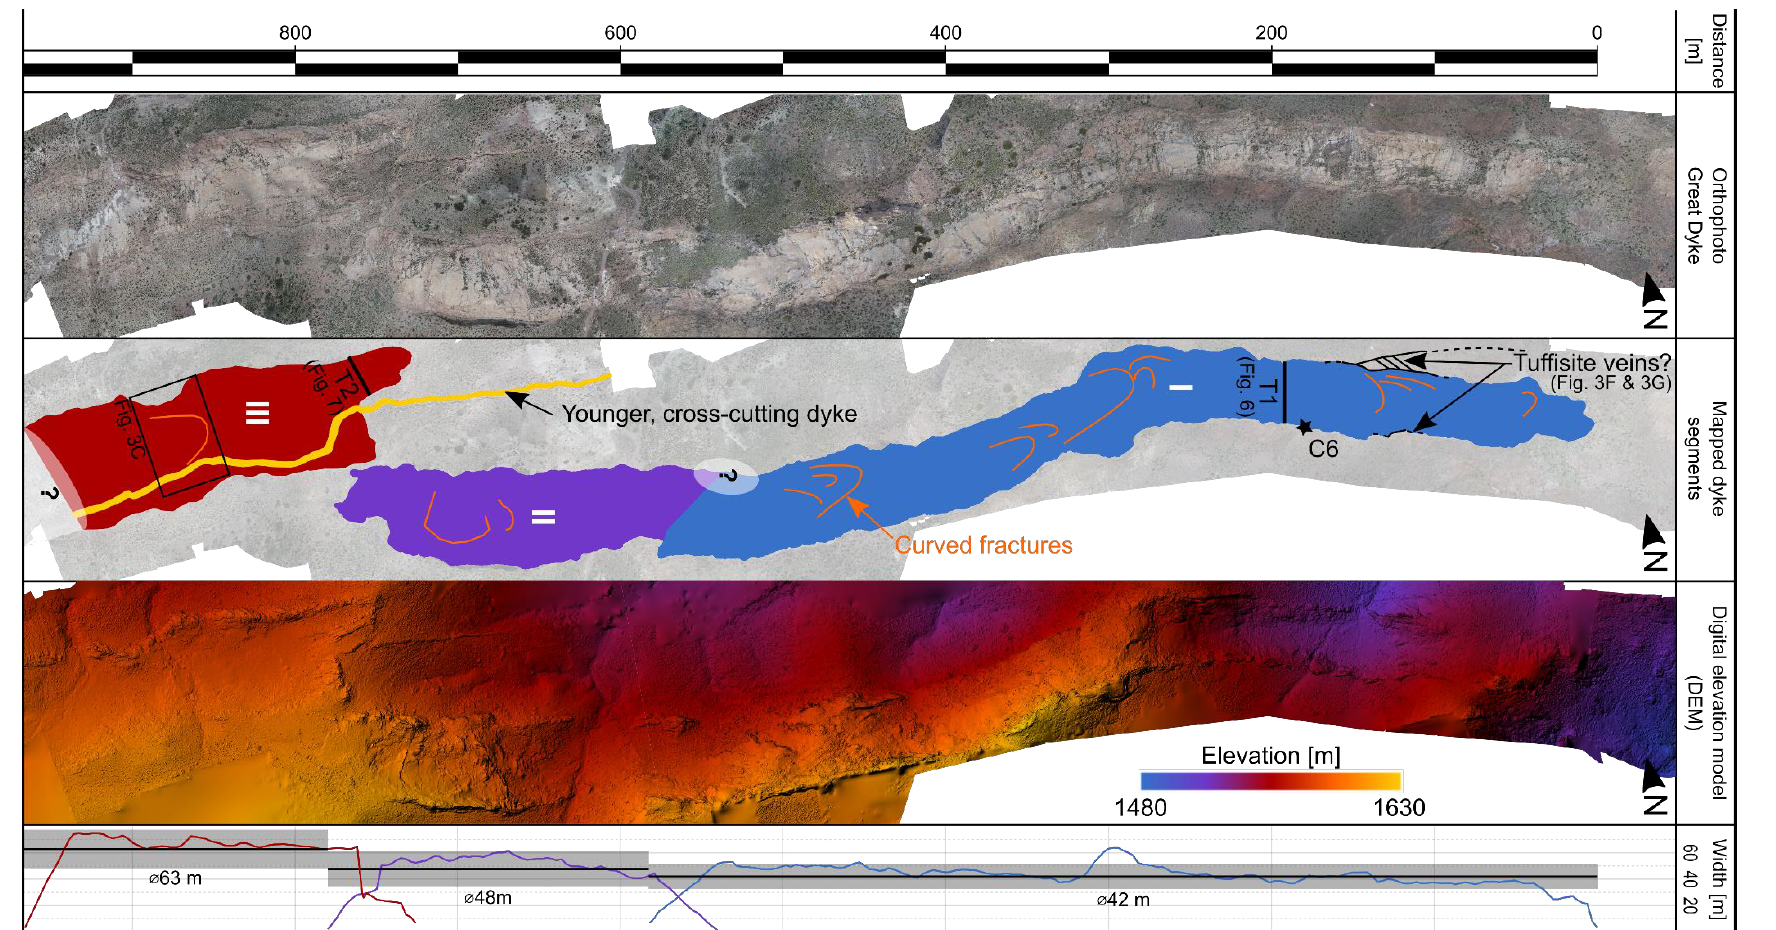
Figure 2. Sosa Dyke overview. (left two columns) Orthophoto with a 10 cm resolution and interpreted orthophoto showing dyke segments ( I-III ); a younger thin dyke cross-cutting the Sosa Dyke and the host rock (yellow); Locations of the sampled and measured traverses T1 and T2, Black star marks sample location for geochemistry sample C6; Curved large scale fractures (orange); and areas with uncertain interpretation ( ? ). (second right column) Digital elevation model (DEM) of the Sosa Dyke highlighting the different weathering of the dyke and host rock. (right column) Thickness plot along the dyke length; solid black line and value describe the average thickness; Standard deviation (grey zone); Thickness measurements with 5 m spacing (coloured lines).